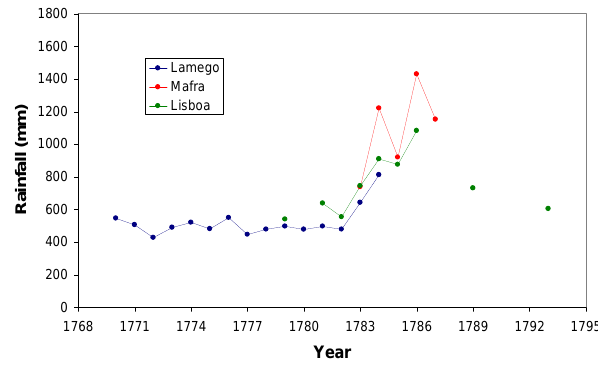
Fig. 4. Annual totals of rainfall in three meteorological Portuguese Figure 4. Annual totals of rainfall in three meteorological Portuguese sites in the 18 th 2 sites in the 18th century (Taborda et al., century (Taborda et al., 2004).